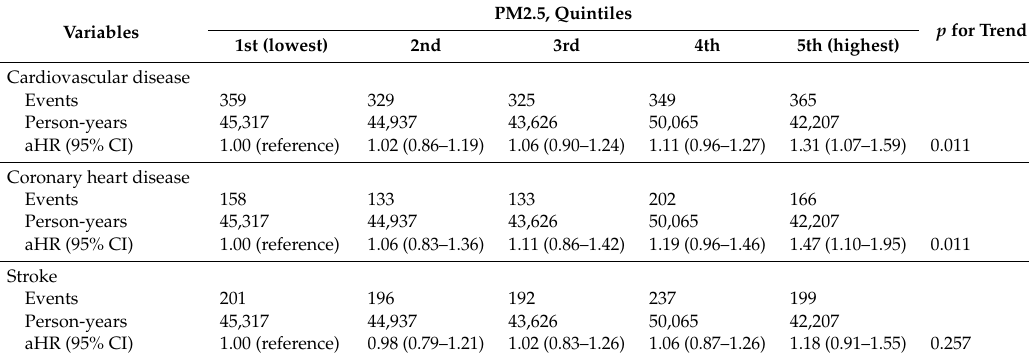
Table 2. Adjusted hazard ratios (95% CI) for cardiovascular disease according to post-diagnosis PM2.5 levels among 5-year cancer survivors. PM2.5,